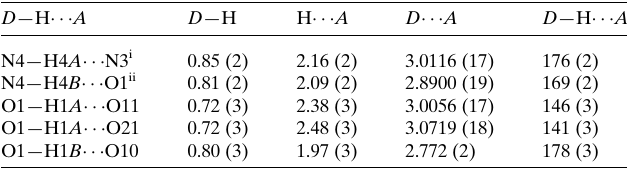
Table 2 Hydrogen-bond geometry (A˚ , (cid:3) ).